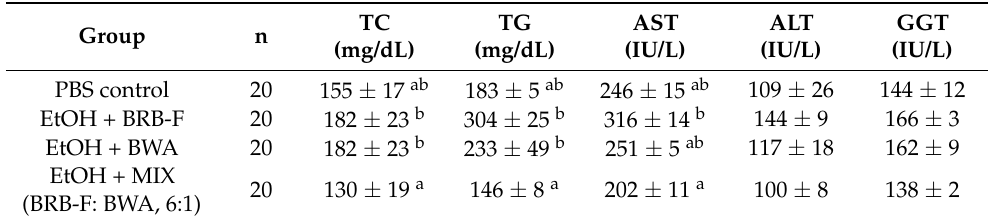
Table 2. Effect of BRB-F, BWA, and MIX in alcohol liver injury zebrafish for 17 days on plasma lipid profile and liver toxicity